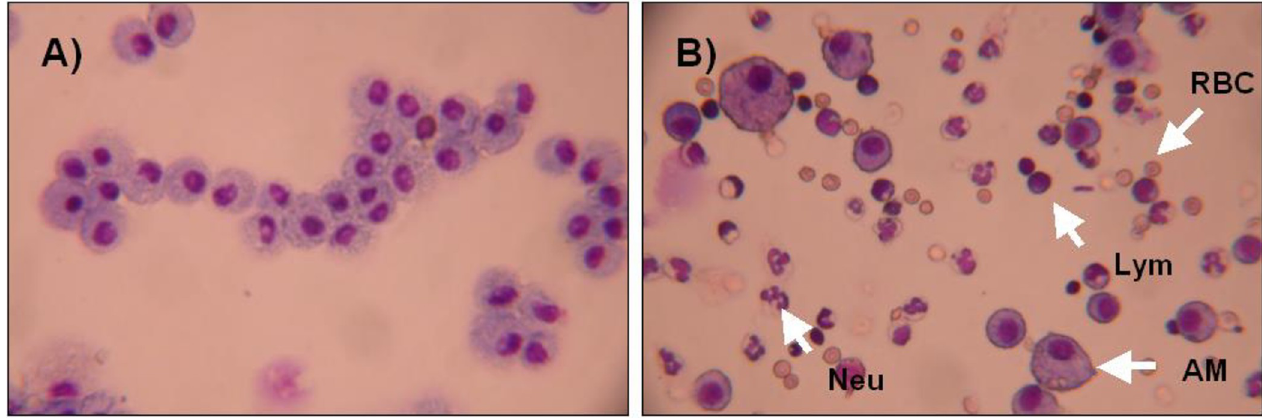
Fig 12. Cytospin pictures after blast exposure. A) sham control, B) 24 hours after blast exposure. AM: alveolar macrophages; Neu: neutrophils; Lym: lymphocytes; RBC: red blood cells.